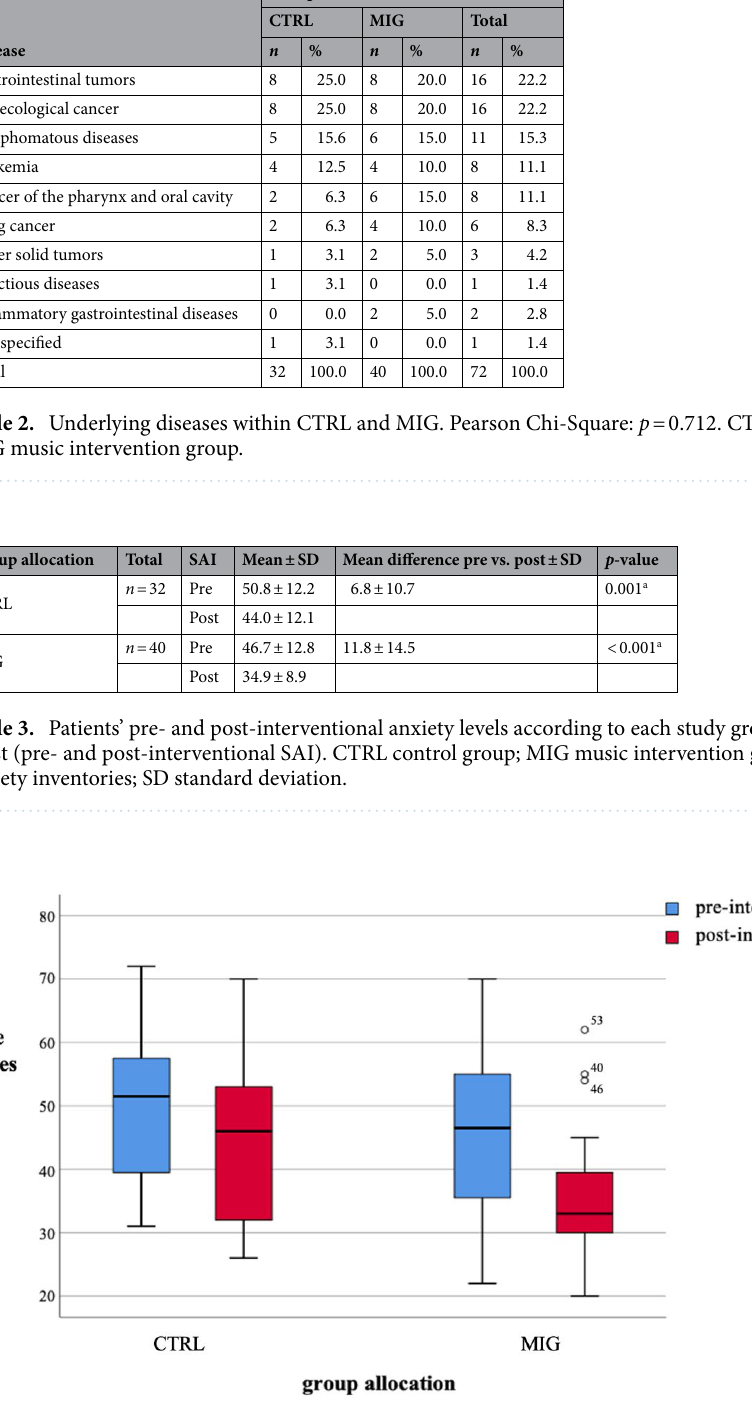
Figure 3. Comparison of patients’ pre- and post-interventional anxiety levels. CTRL control group; MIG music intervention group; SAI state anxiety